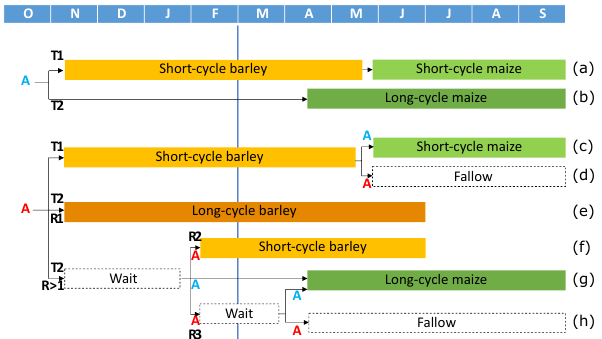
Figure 3. Crop options considered in the model for farmers. Blue and red As represent respectively good and poor water availability at the moment of the decision. R1, R2 and R3 mark the different courses of action that farmers can follow depending on the risk they are willing to take, with R1 being the most risk averse and R3 the least risk averse. The lower case letters a–h indicate the end points of the possible decision paths. The blue vertical line marks the start of the irrigation